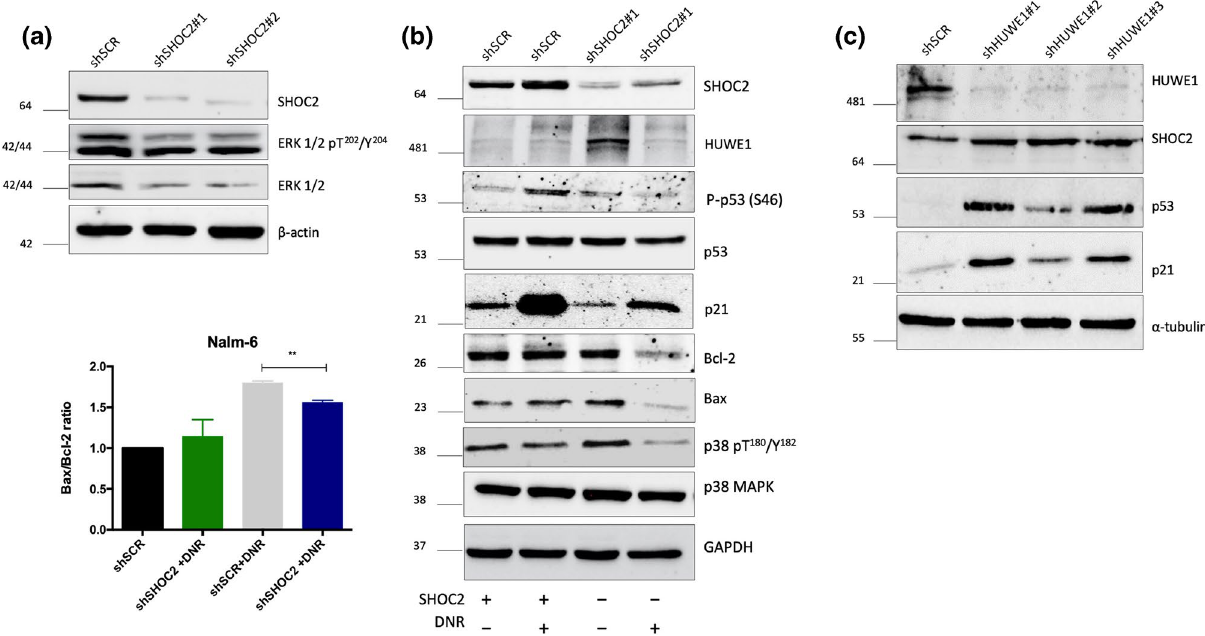
Figure 3. ( a ) Representative immunoblot of SHOC2 knockdown (obtained from two independent shRNA) significantly impaired ERK1/2 phosphorylation. ( b ) Combined genetic inhibition of SHOC2 with Daunorubicin treatment for 24 h (40ηM) in Nalm-6 cells. Immunoblots reveal reduced p53 expression, impaired Serine 46 phosphorylation and consequently reduced p21 expression upon Daunorubicin-induced damage. Important apoptotic effectors were also affected as observed for p38 phosphorylation inhibition and reduced BAX/BCL-2 ratio (representative bar-graph in the left panel). ( c ) HUWE1 knockdown in Nalm-6 cells greatly increased SHOC2, p53 and p21 expression, confirming SHOC2-p53 interaction. As observed in immunoblot panel in ( b ) after Daunorubicin-induced damage, in SHOC2 absence decreased p53 phosphorylation and also reduced HUWE1